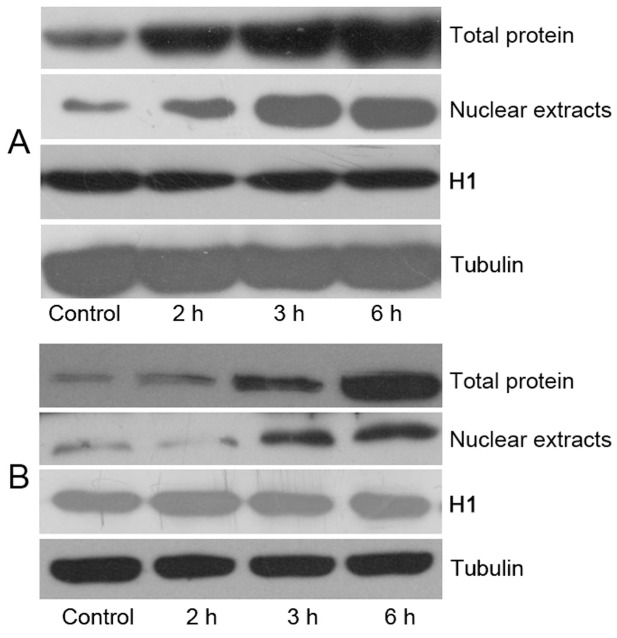
KGF administration resulted in an increased IRF-1 and IRF-2 expression of the nuclear extracts and total proteins in vitro.Dose-dependent increased expression both of IRF-1 (A) and IRF-2 (B) were confirmed by western blot in LoVo cells with KGF treatment. Tubulin and H1 were used as internal control.